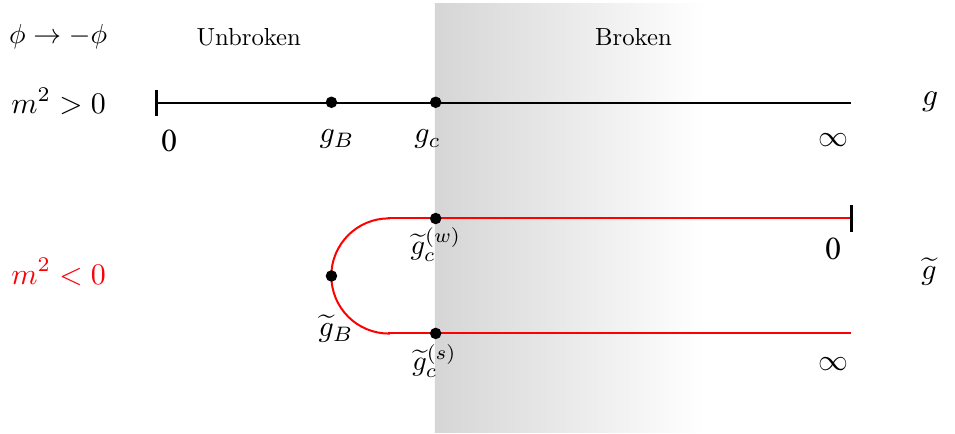
Figure 1 . Phase structure of the (cid:30) 4 theory according to Chang duality, as a function of the couplings g and g . Points in the same vertical line connecting the black and red lines correspond to di(cid:11)erent descriptions of the same e